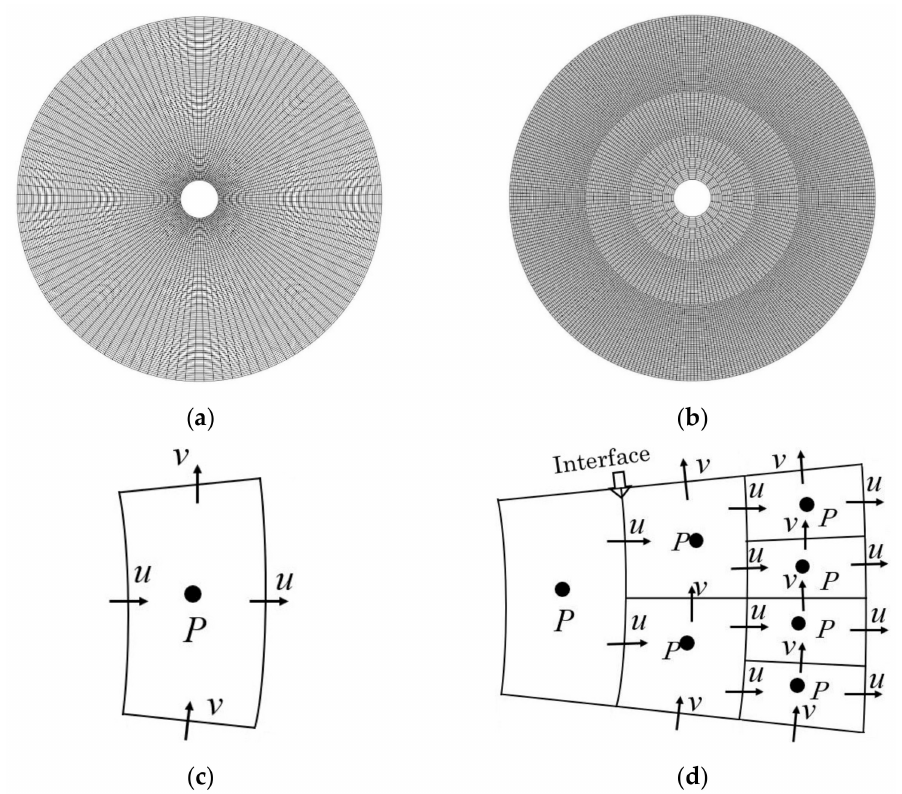
Figure 1. Grid arrangement in computational domain: ( a ) Regular grid system, ( b ) Zonal embedded grid system, ( c ) staggered grid arrangement at a normal cell, and ( d ) staggered grid arrangement at the interface of coarse and fine blocks